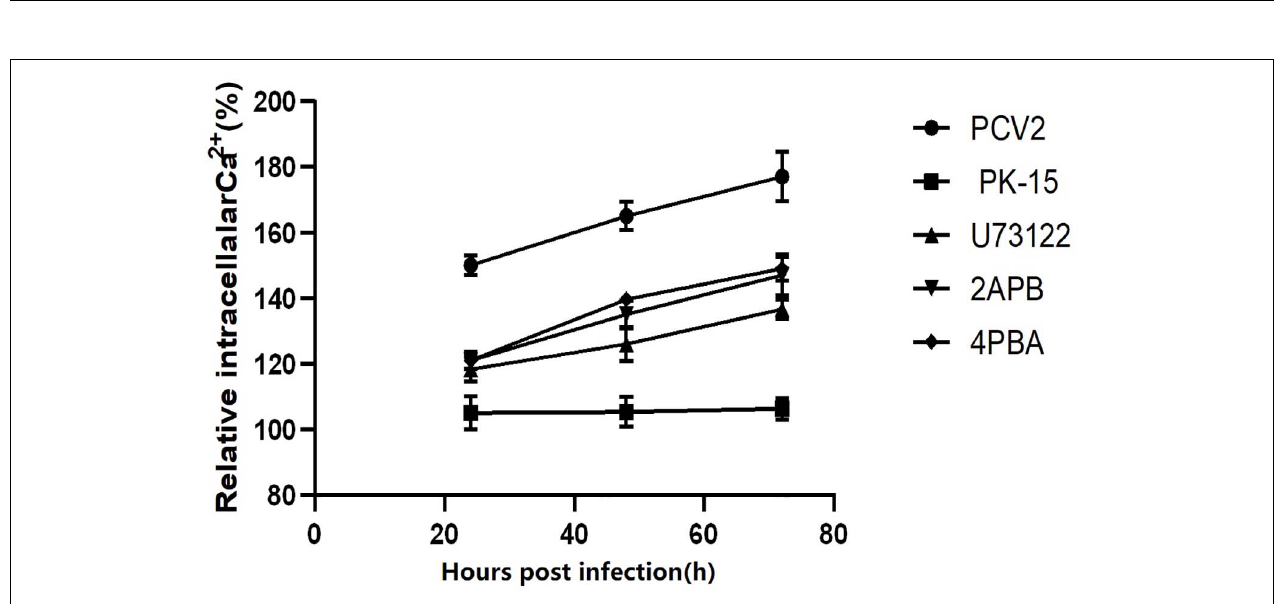
FIGURE 7 | Changes of Ca 2 + after virus infection. The different marked lines in the figure represent the changes of intracellular Ca 2 + concentration in different periods of virus infection and PK-15 cells after adding different inhibitors, showing the influence of inhibitors on Ca 2 + concentration.